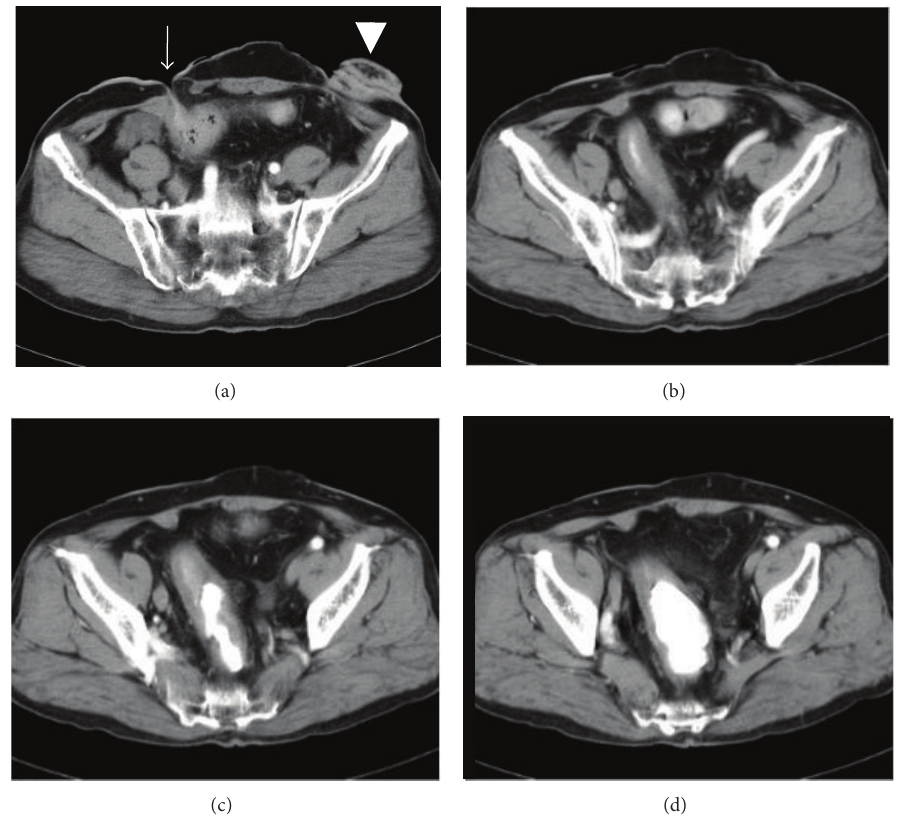
Figure 3: CT performed after surgery indicated that the rectal dilation had resolved ((a), (b), (c), and (d)). A mucous fistula of the upper rectum was created in the right lower abdomen (arrow). A sigmoid divided colostomy was created in the left lower abdomen (arrow